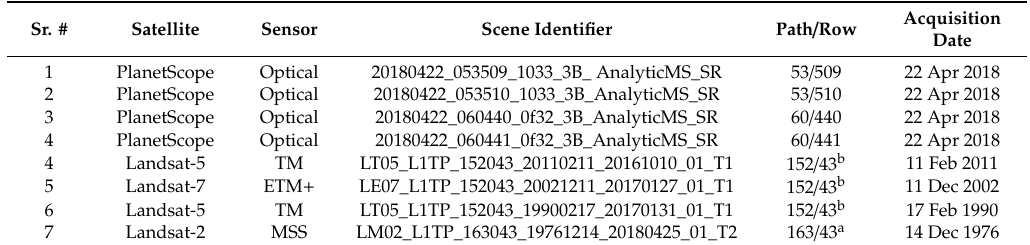
Table A1. List of satellite images used in this